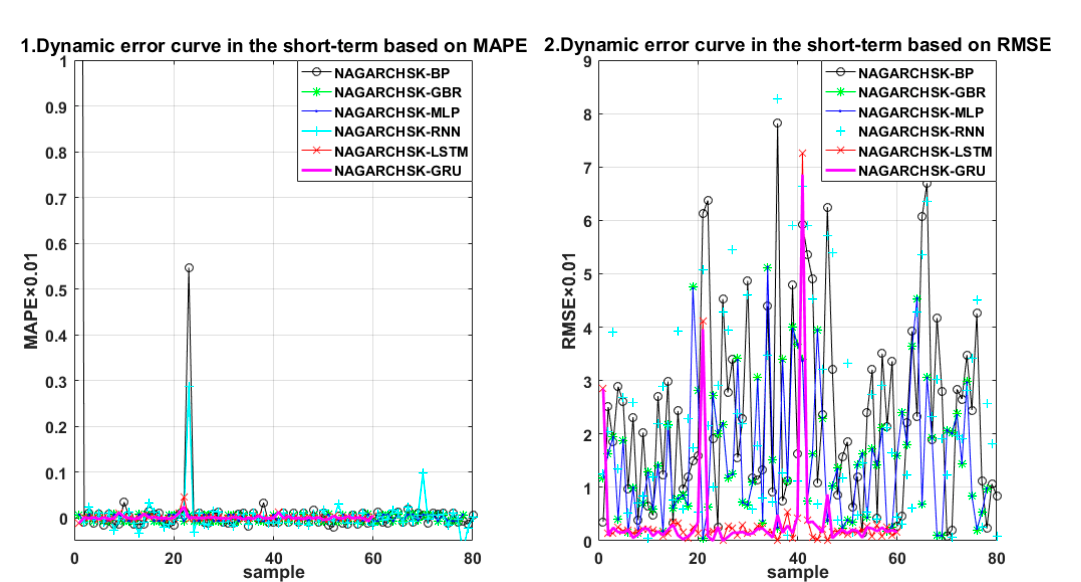
Figure 7. Error scatter distribution of the proposed and benchmark forecasting models considering the feature of time varying, high-order moment in the long term.